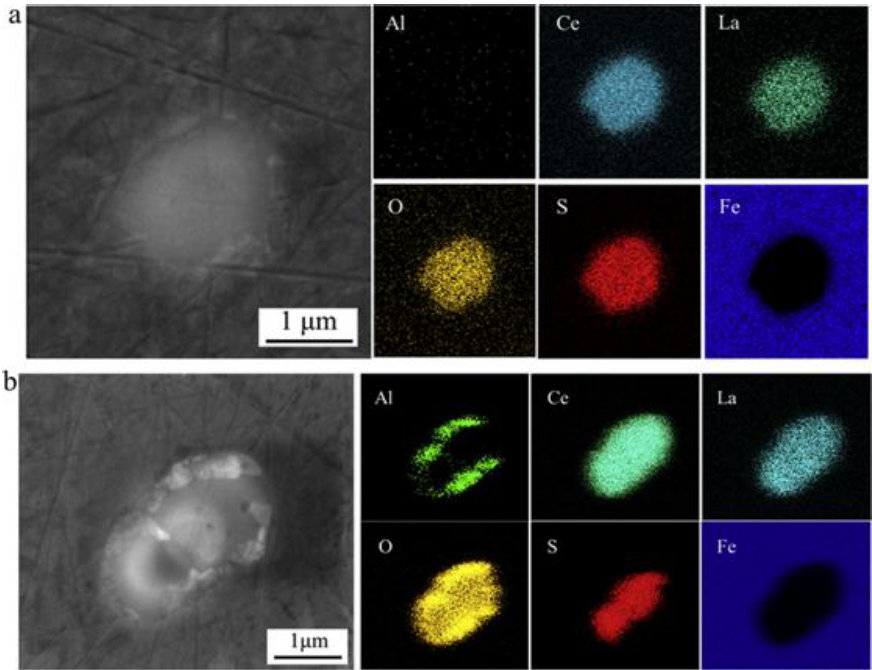
Figure 5. SEM-EDS images of inclusions in the sample steel. ( a ) Morphology and elemental distri- bution of (RE)2O2S-(RE)xSy; ( b ) morphology and elemental distribution of (RE)AlO3-(RE)2O2S-(RE)xSy [52]. Reproduced with permission of Elsevier, copyright 2017.